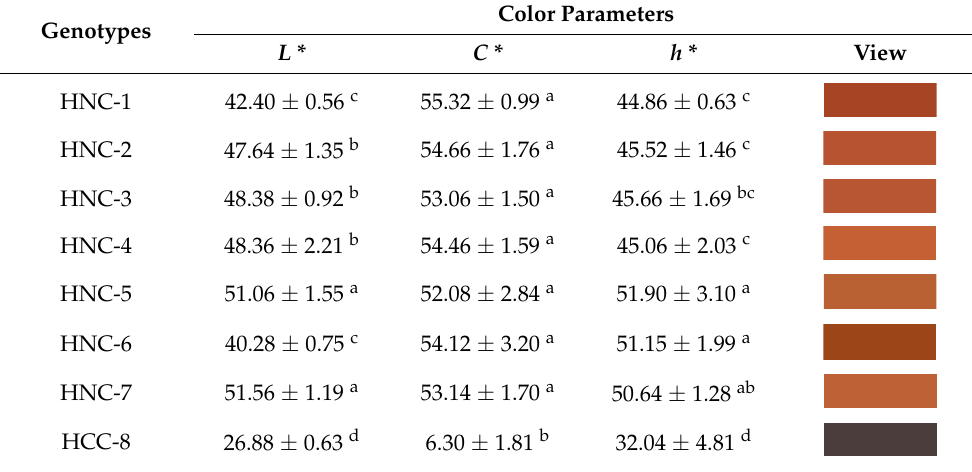
Table 3. Chromatic parameters of the fruits of eight genotypes of habanero pepper grown in the southeast of Coahuila.